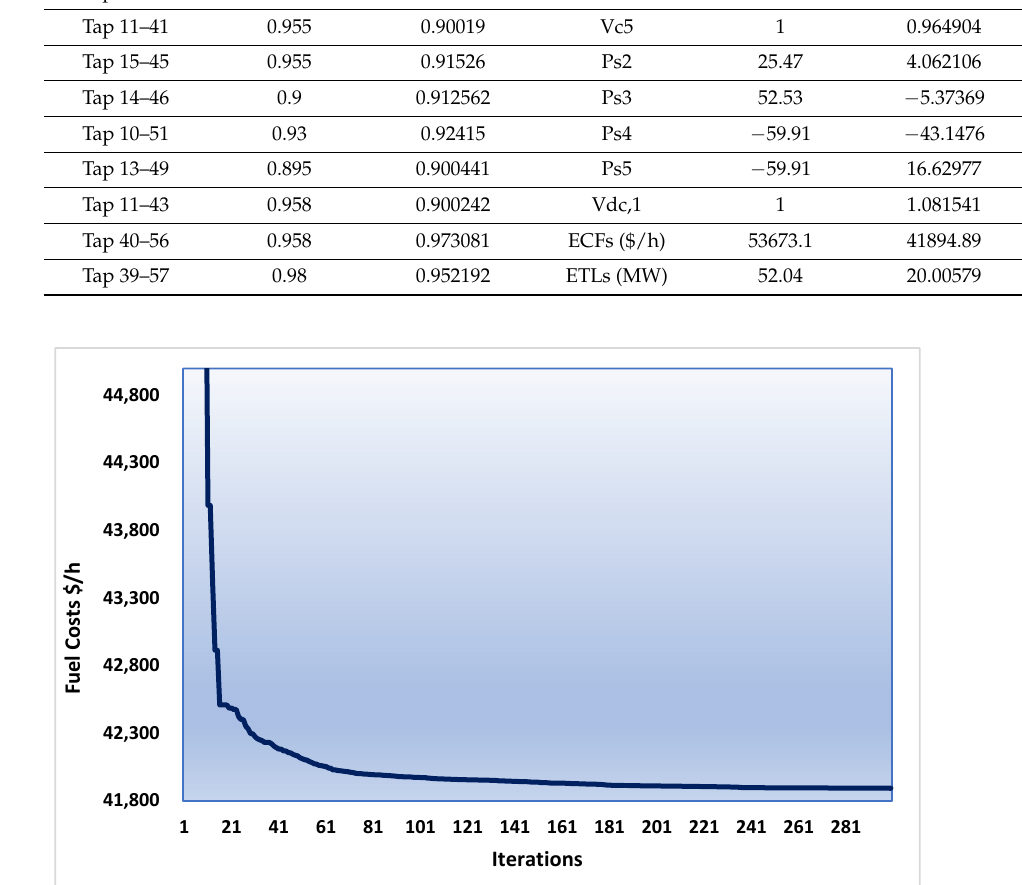
Figure 5. Convergence curves of TLBA for the minimization of the TFCs of the IEEE 57-bus network.